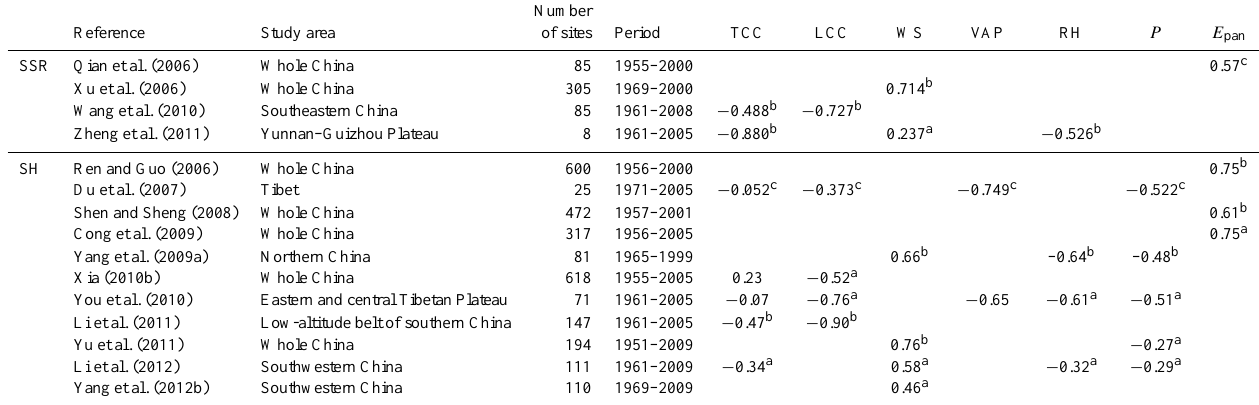
Table 3. Correlation coefficients between radiative (SSR, surface solar radiation; SH, sunshine hours) and meteorological (TCC, total cloud cover; LCC, low cloud cover; WS, wind speed; VAP, water vapor pressure; RH, relative humidity; P , precipitation; E pan , pan evaporation)